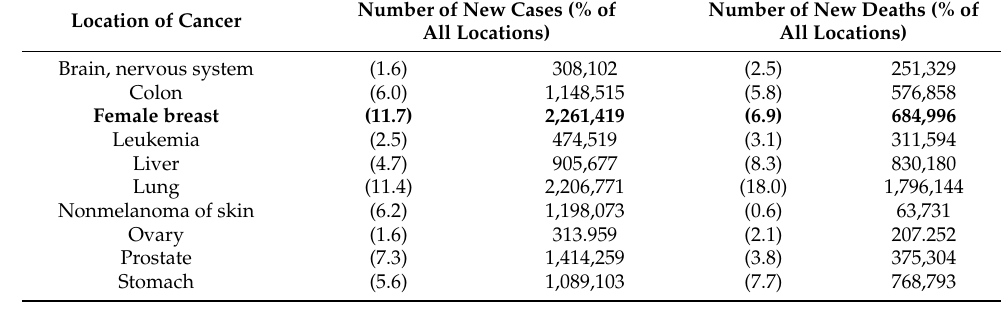
Table 1. New cases and deaths for 10 cancer types in 2020.